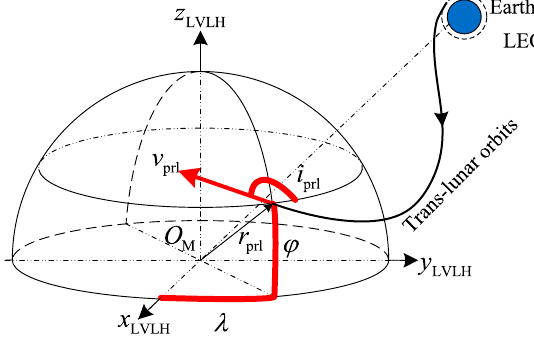
Fig. 4 Illustration of the orbital design variables at the moment of